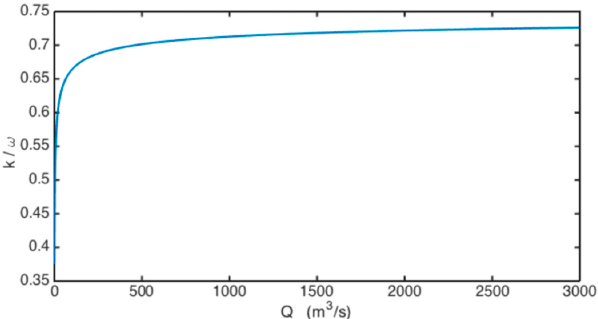
Figure 3. Ratio between equivalent duration k and ω as a function of the discharge. It can be noticed that the ratio k/ ω tends to stabilize when Q tends to increase.